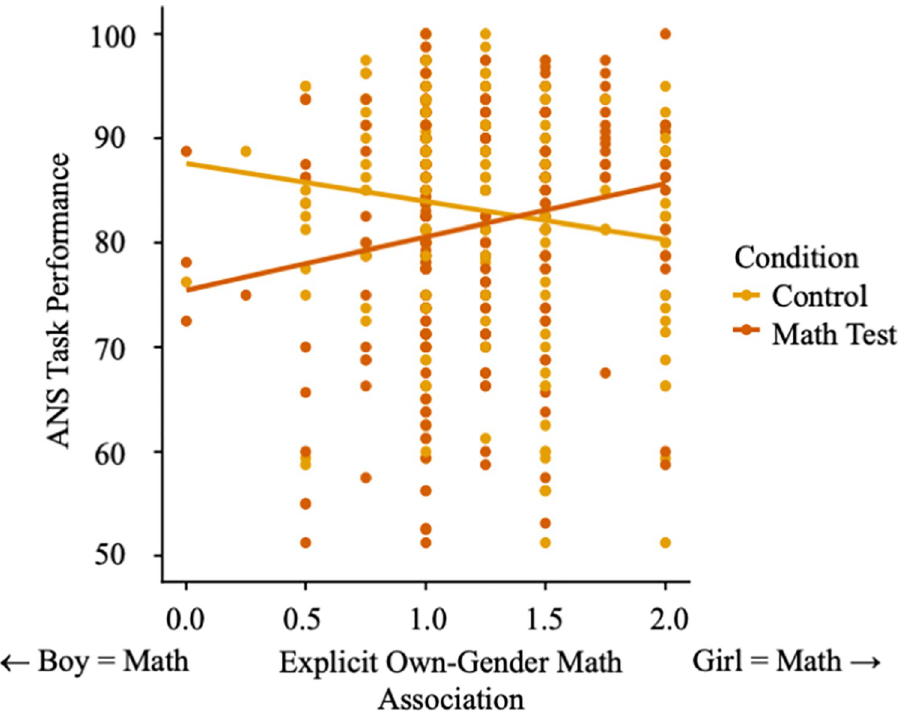
Fig 2. Girls’ ANS task performance by